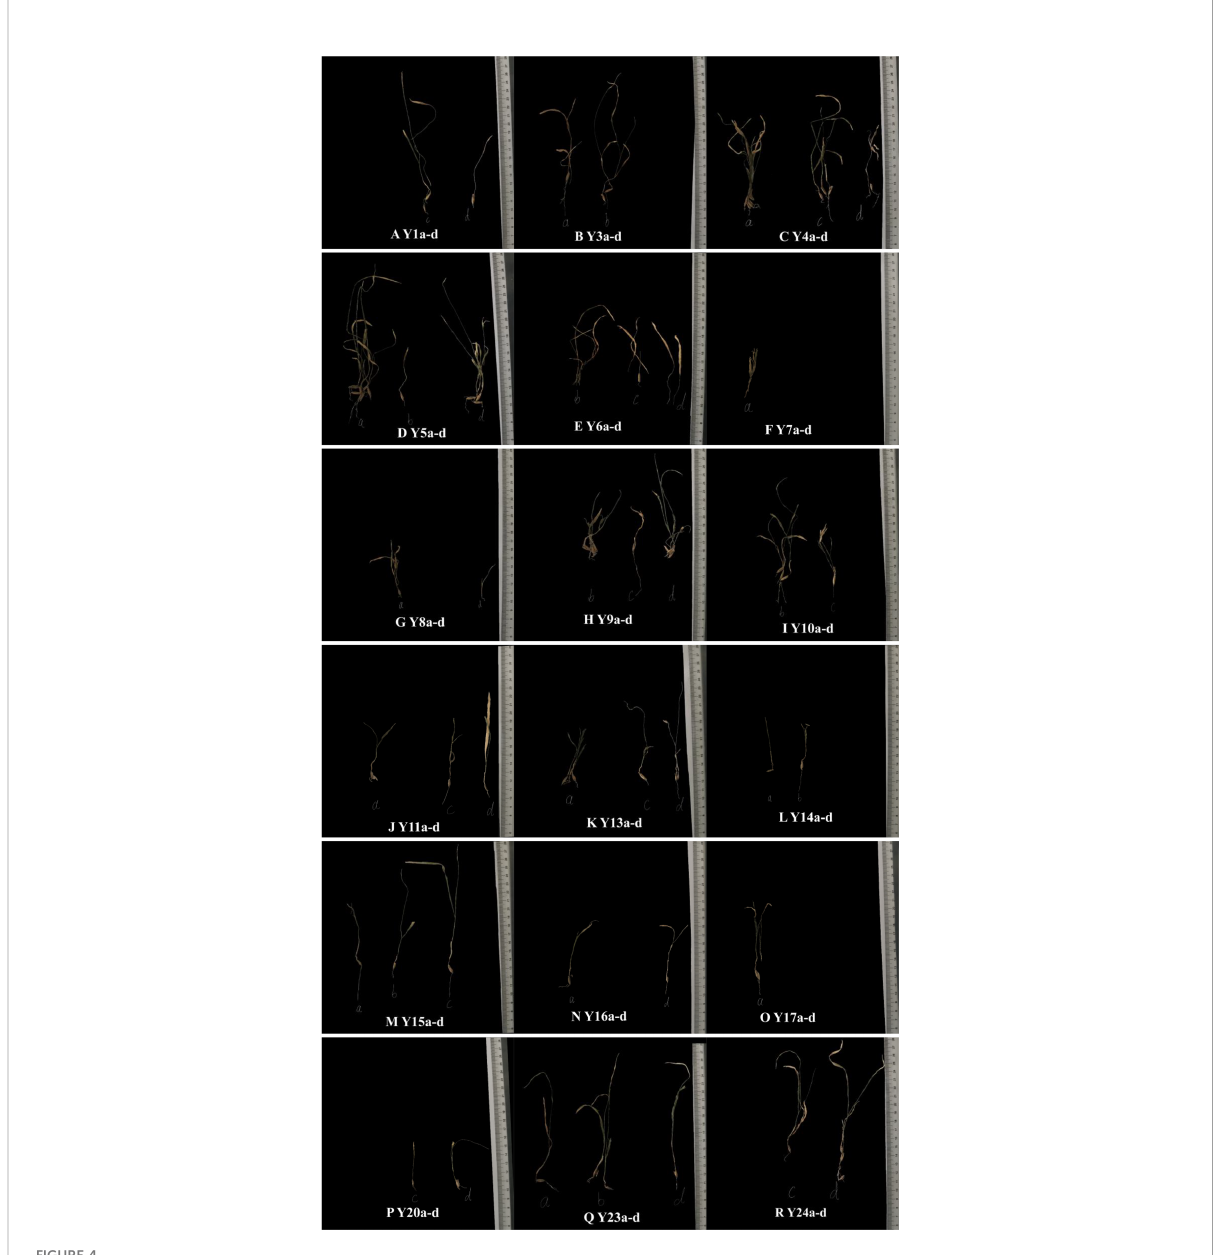
FIGURE 4 Final growth status of test plants after 30